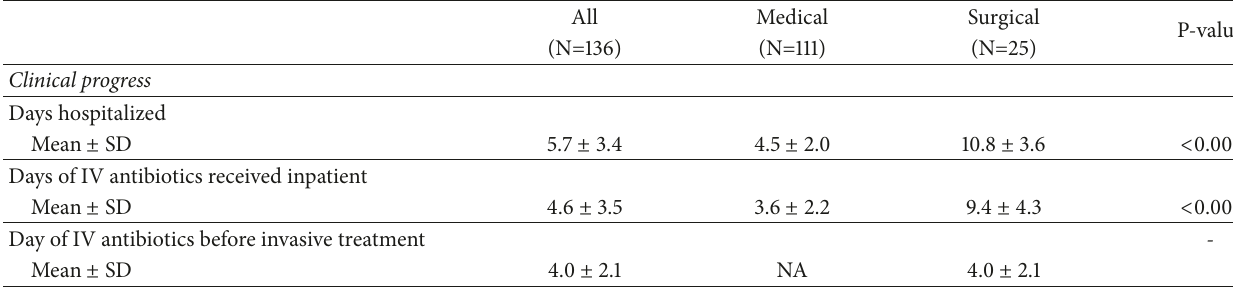
Table 4: Comparison of clinical progress between the two patient groups.